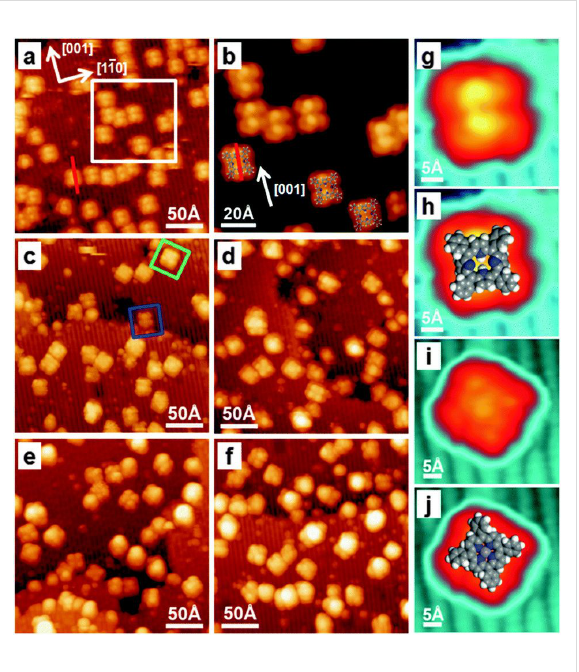
Figure 4: STM images of 2H-TPP and NiTPP molecules on the TiO 2 (110)-(1 × 1) surface. (a) and (b) 2H-TPP molecules imaged before the deposition of Ni atoms. (c–e) STM images obtained